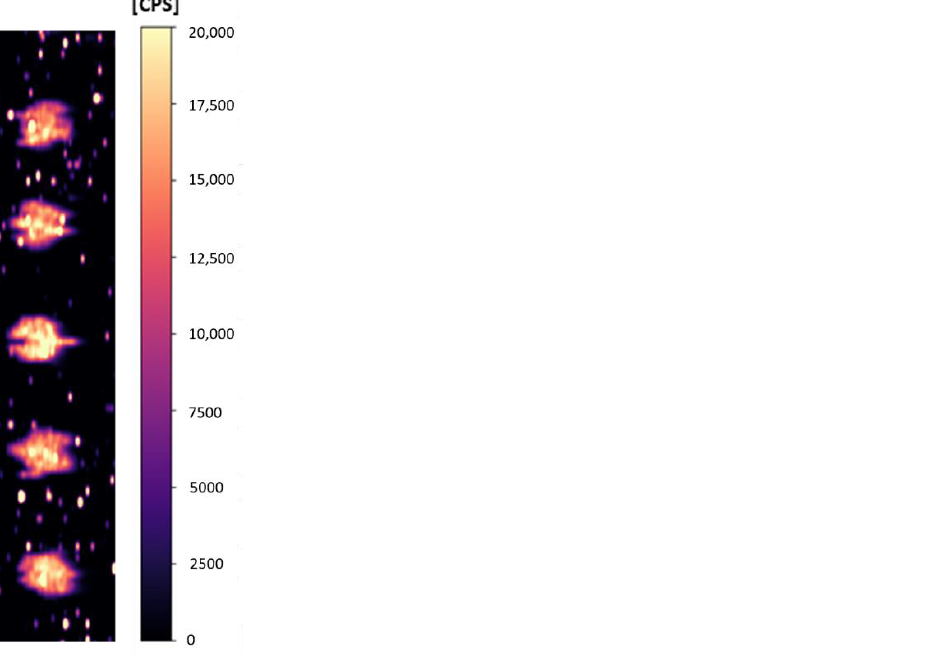
Figure 2. Repeatability of measurement (five 0.5 µ L spots of p53 (4 ng/ µ L) using AuNPs-DO-1).